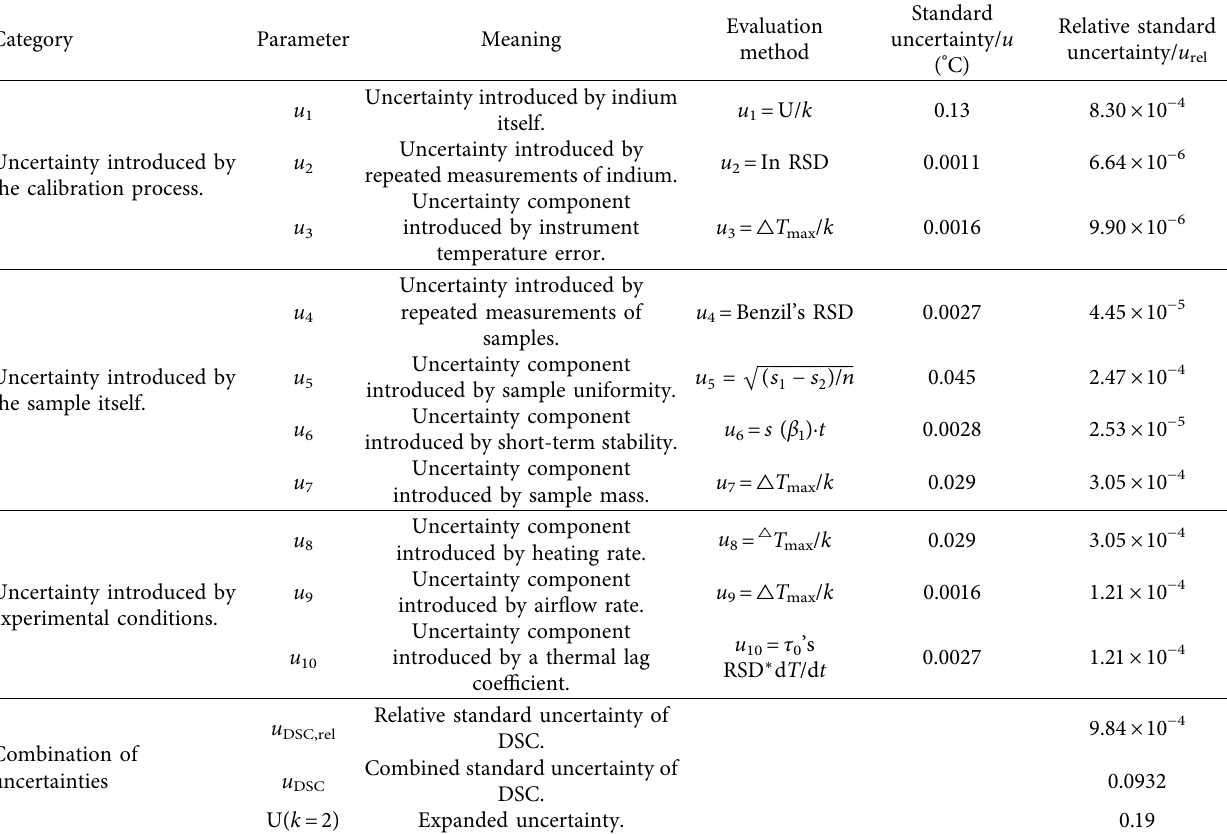
Table 2: Evaluation results of the uncertainty of DSC